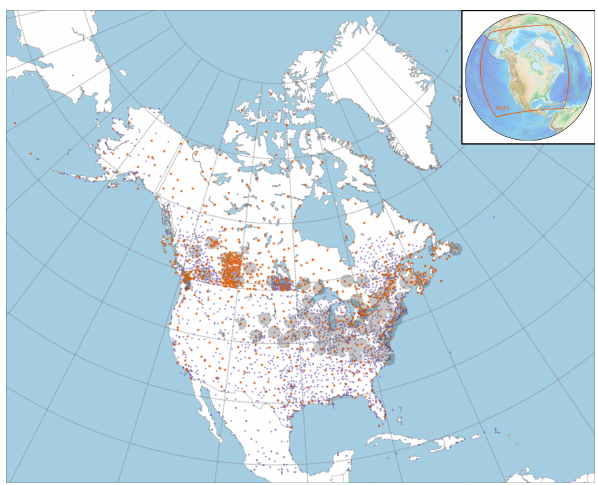
Figure 1. Blue and orange dots represent the various precipitation networks and the surface synoptic observation (SYNOP) stations assimilated in summer 2019, respectively. Shaded gray areas de- note the assimilated portion of radar beams. The inset illustrates the analysis